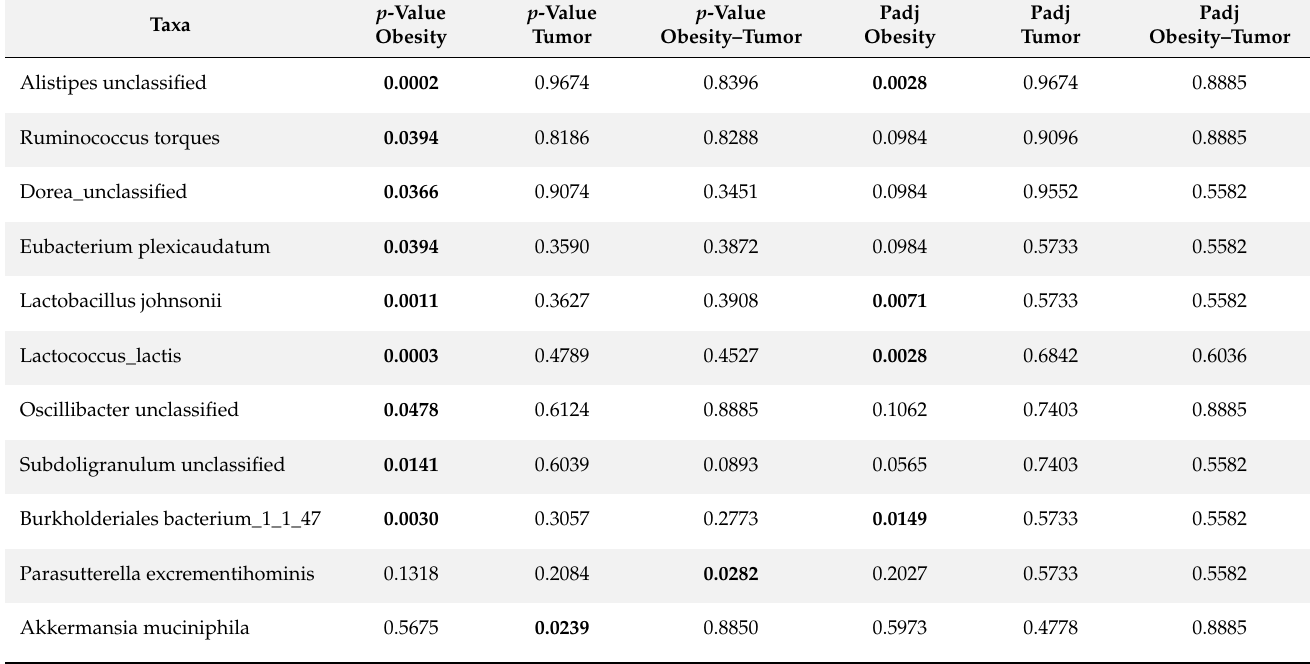
Table 2. Summary of taxa that changed significantly according to obesity and tumor